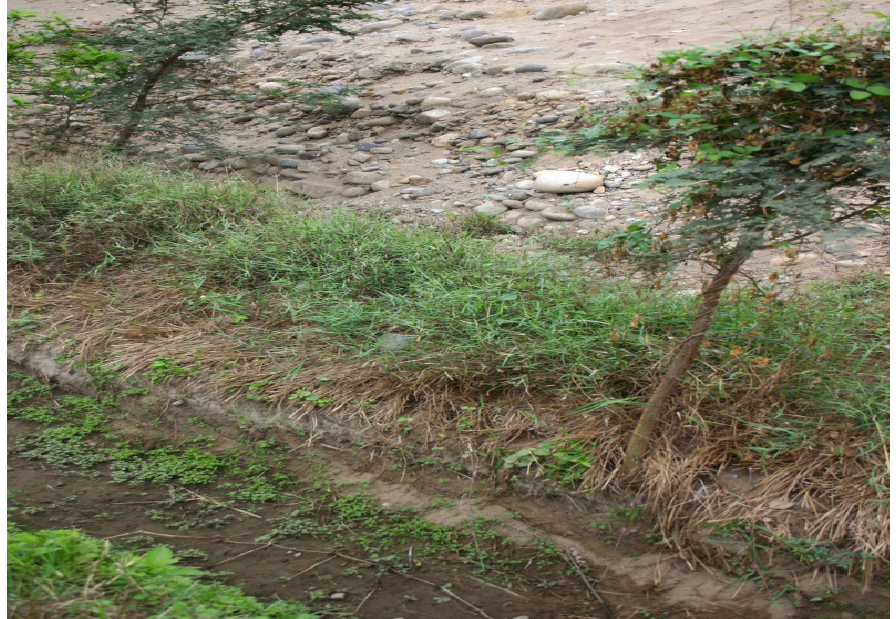
Figure 19. Deposition silt layers at a coastal Supe Valley site resulting from sequential El Niño flood events.